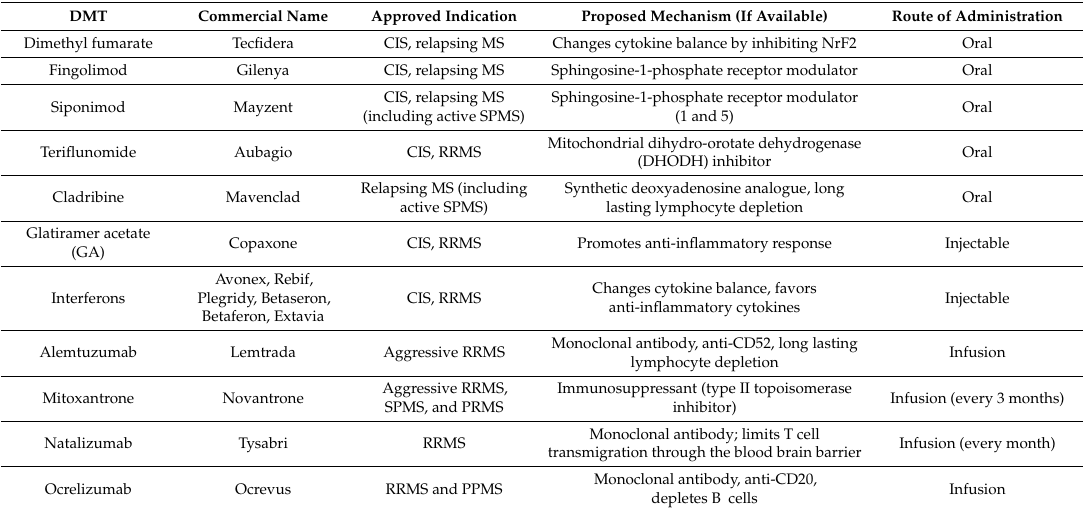
Table 1. Mechanism of action of FDA-approved